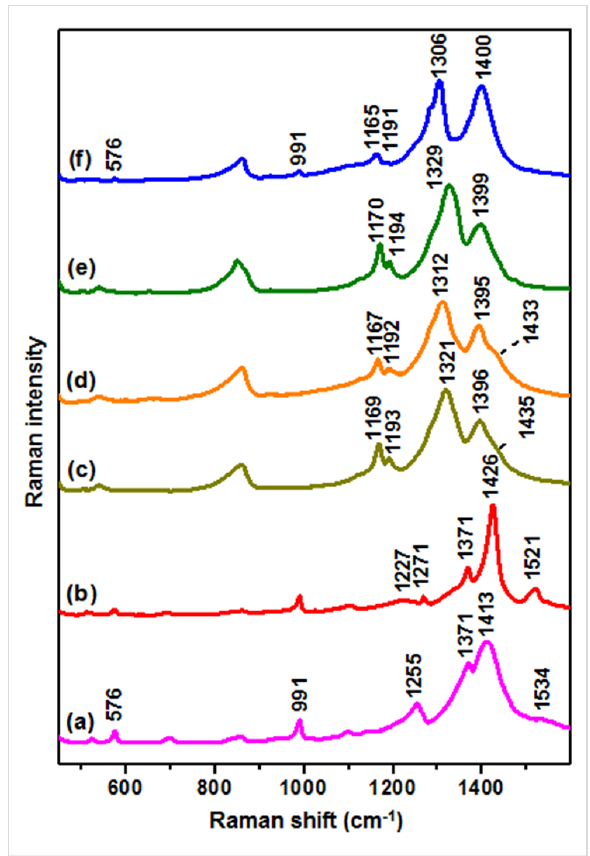
Figure 2: Normalised Raman spectra of (a) doped PEDOT monolayer; (b) de-doped PEDOT monolayer; (c) doped PEDTT monolayer; (d) de-doped PEDTT monolayer; (e) doped PEDOT/PEDTT bilayer; (f) de-doped PEDOT/PEDTT bilayer.